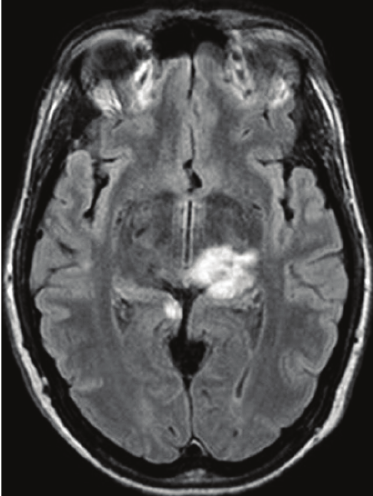
Figure 1: MRI brain T2 axial FLAIR sequence showed hyperinten- sities in the left thalamus and right mesial occipital lobe.